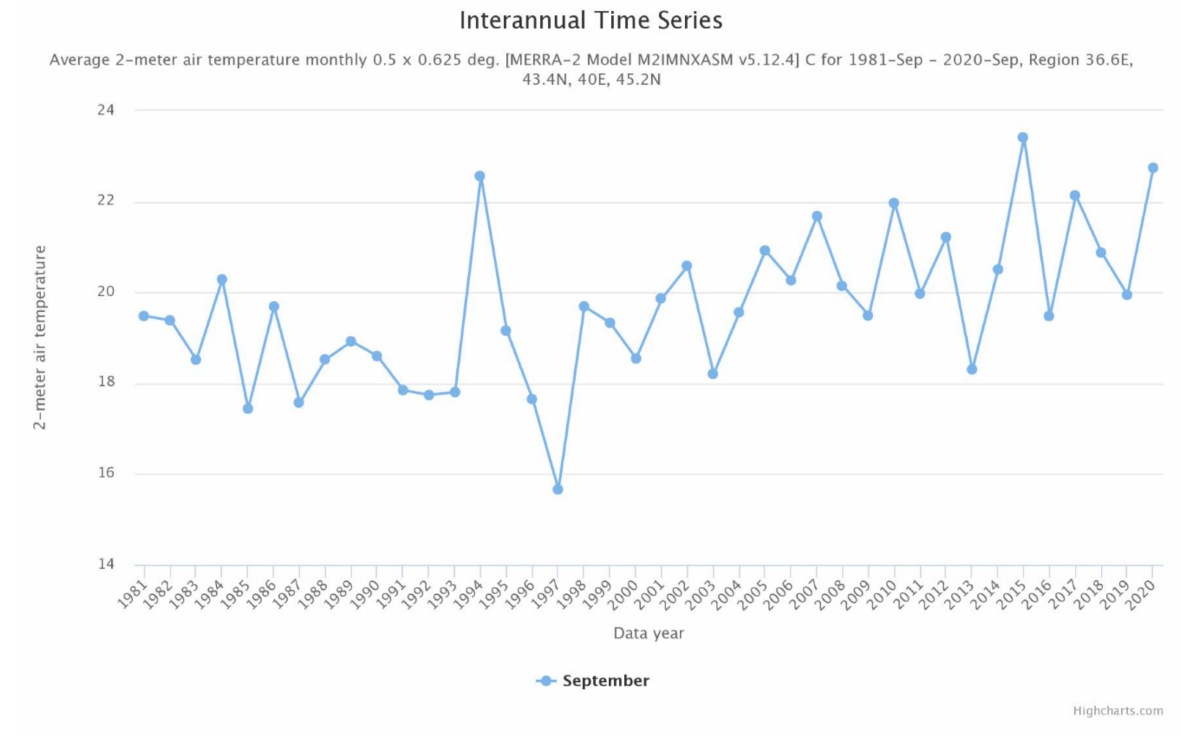
Figure 4. Interannual variability of the near-surface air temperature over the northeastern Black Sea in September from 1981–2020 based on the MERRA-2 M2IMNXASM_5.12.4